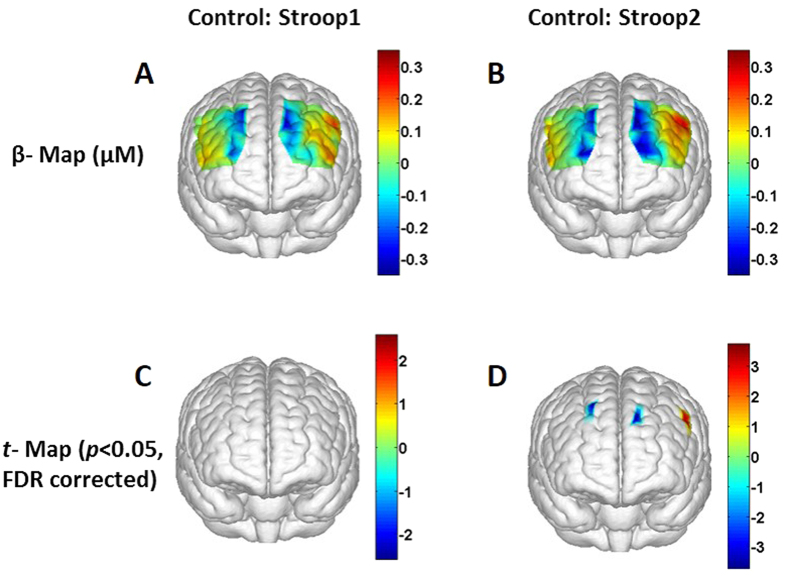
Topographic images of the task-evoked prefrontal activations derived from changes in HbO2 in control group.(A) Group-averaged prefrontal activation (β-map in μM) evoked by Stroop1 tasks; (B) Group-averaged β-map (in μM) evoked by Stroop2 tasks. (C) A t-statistical map (t-map) that shows significant activations and/or deactivations (one sample t-test, p < 0.05; FDR corrected) on the brain template during Stroop1 tasks. (D) A t-map showing significant activations and/or deactivations evoked by Stroop2 tasks.